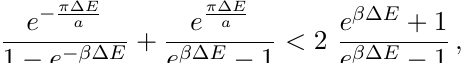
√ (cid:0) (cid:1) |I ε | − I A I B